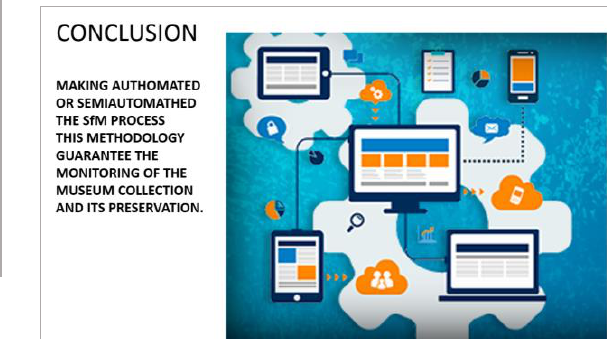
Figure 21. The automation of the SfM process will simplify the